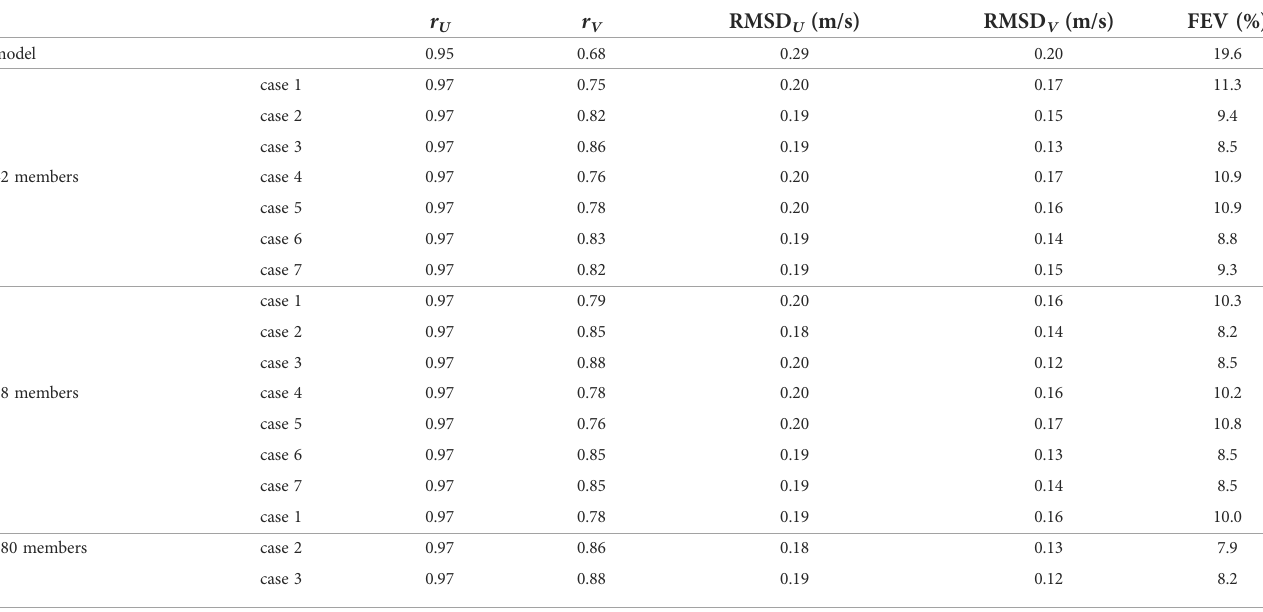
TABLE 4 Summary of the comparison with ADCP observed currents for all the test cases listed in Table